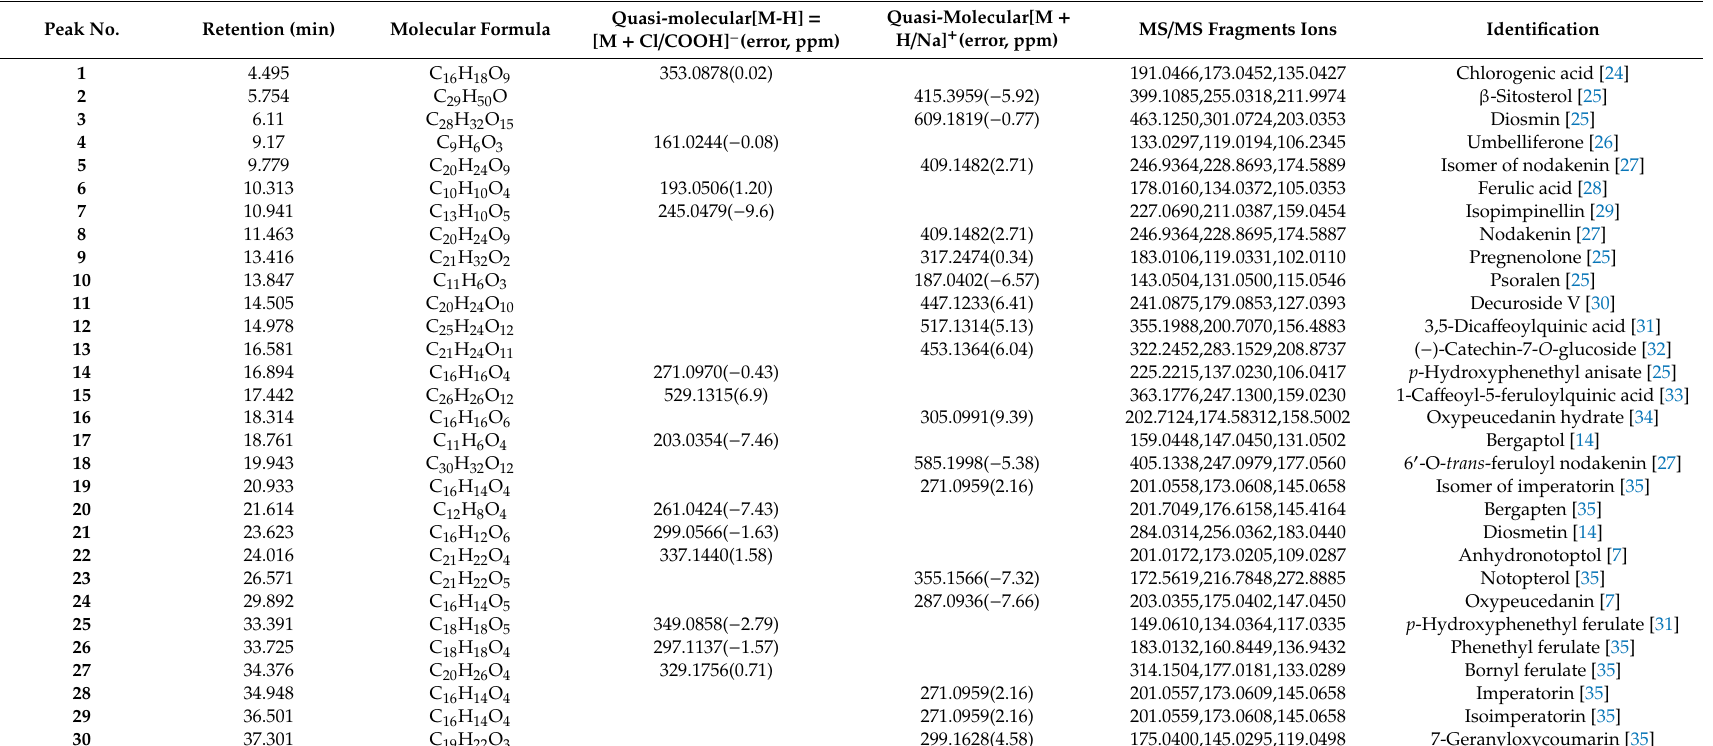
Table 3. The compounds identified in the TIC